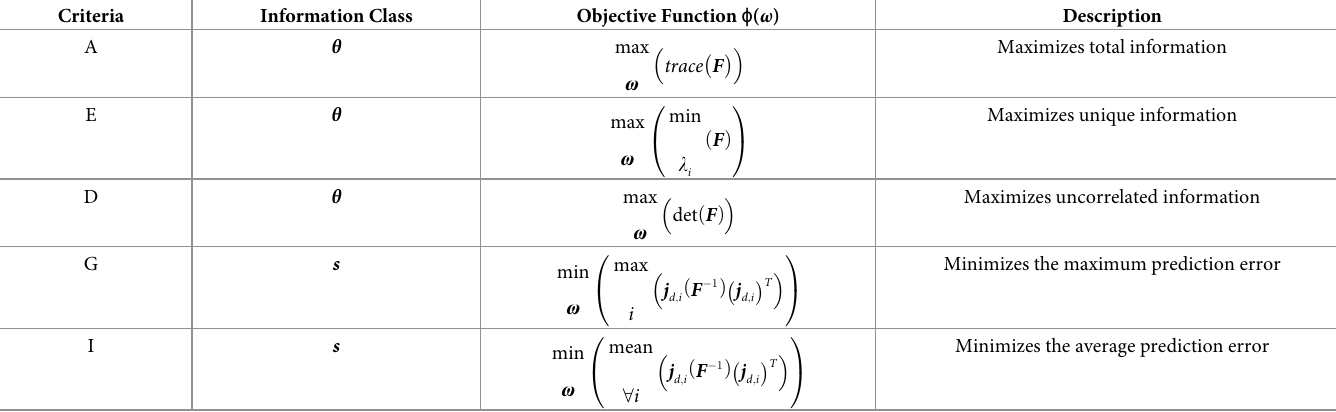
Table 1. Optimality